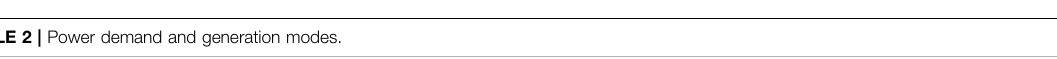
TABLE 2 | Power demand and generation